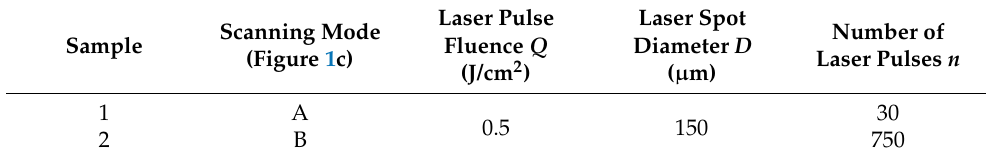
Table 1. Sample processing